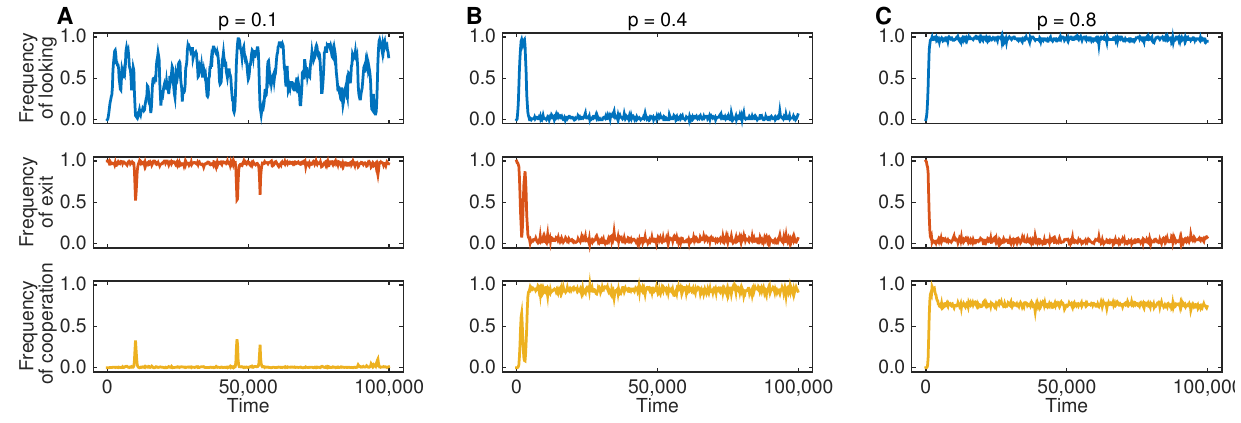
Three representative simulation runs for different combinations of p (the probability that Player 1 has a low defection payoff). The populations’ evolution depends on the game parameters: ( A ) for p = 0 . 1 the dynamics lead to an EXIT equilibrium: individuals in Population 2 exit the interaction, irrespective of Player 1’s looking decision in the second stage; ( B ) for p = 0 . 4 , individuals in Population 1 quickly learn not to look and to cooperate, whereas individuals in Population 2 learn not to exit; ( C ) for p = 0 . 8 , the evolutionary simulations lead to an ONLYL equilibrium, as predicted by backward induction. For the simulations, we have used the game parameters a = b = 4 , c d = − 10 , d = − 2 and λ = 0 . The population parameters are as follows: population 1 2